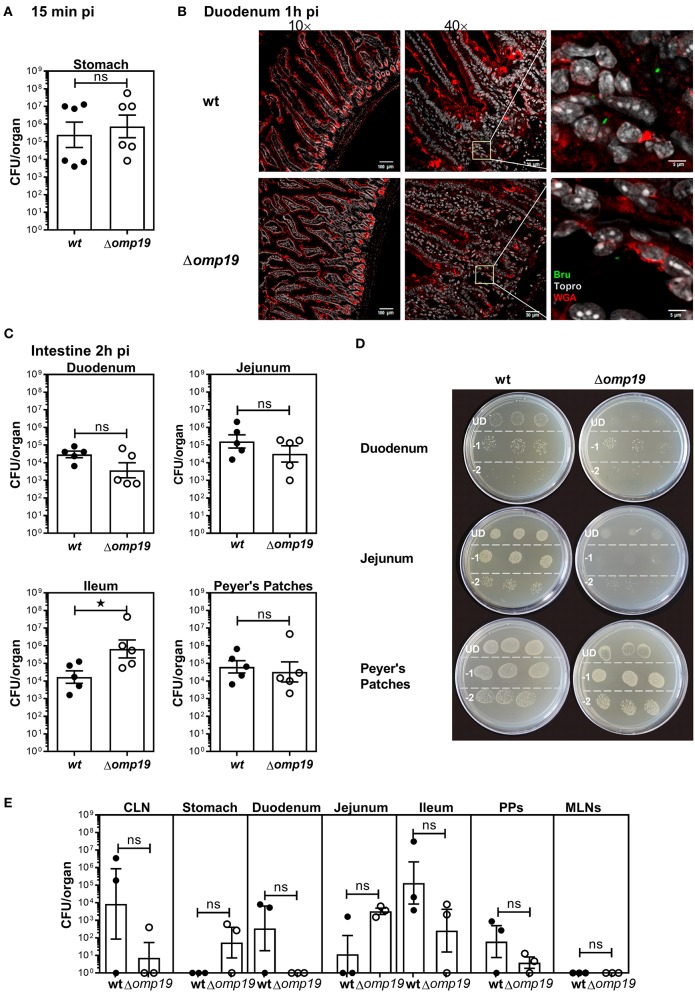
Brucella abortus requires Omp19 to evade the bacteriostatic action of intestinal content. BALB/c mice were i.g. inoculated with (1 × 109 CFU) of wt or Δomp19 B. abortus strains. (A) Total CFUs per stomach in animals sacrificed at 15 min post-infection. Each point represents an individual mouse, horizontal lines, and error bars represent the mean ± s.e.m. (B) Confocal microscopy images of duodenum of infected mice at 1 h post-infection. The images correspond to ROI merged signals for Brucella (green channel), mucin (WGA) (red channel) and nuclei (TO-PRO-3, NIR channel). The inset region of middle images (40×) was magnified and presented in the right, showing individual Brucellae in the epithelium. Scale bars are: 100 μm (left panels), 30 μm (middle panels) and 5 μm (right panels). (C) Total B. abortus CFUs recovered from duodenum, jejunum, Ileum or Peyer's Patches from infected mice sacrificed at 2 h post-infection. (D) Representative agar plates showing sequential 1:10 dilutions and drop plating from depicted tissues homogenates from wt or Δomp19 infected mice. UD (undiluted), −1: 1 to 10 dilution; −2: 1 to 100 dilution. Results are representative of two independent experiments. (E) BALB/c mice were inoculated at the oral cavity with wt or Δomp19 B. abortus (1 × 1010 CFU/mouse). Two hours after infection the number of CFU at CLNs, Stomach, Duodenum, Jejunum, Ileum, PPs, and MLNs were quantified. Each bar represents the mean CFU/organ (logarithmic sc±ale) and error bars represent the mean ± s.e.m. (For some mice, no live bacteria were recovered, these were arbitrarily assigned with values of 1 CFU). (Statistical analysis was performed by unpaired t-test to compare between the indicated groups: nsp > 0.05; *p < 0.05).